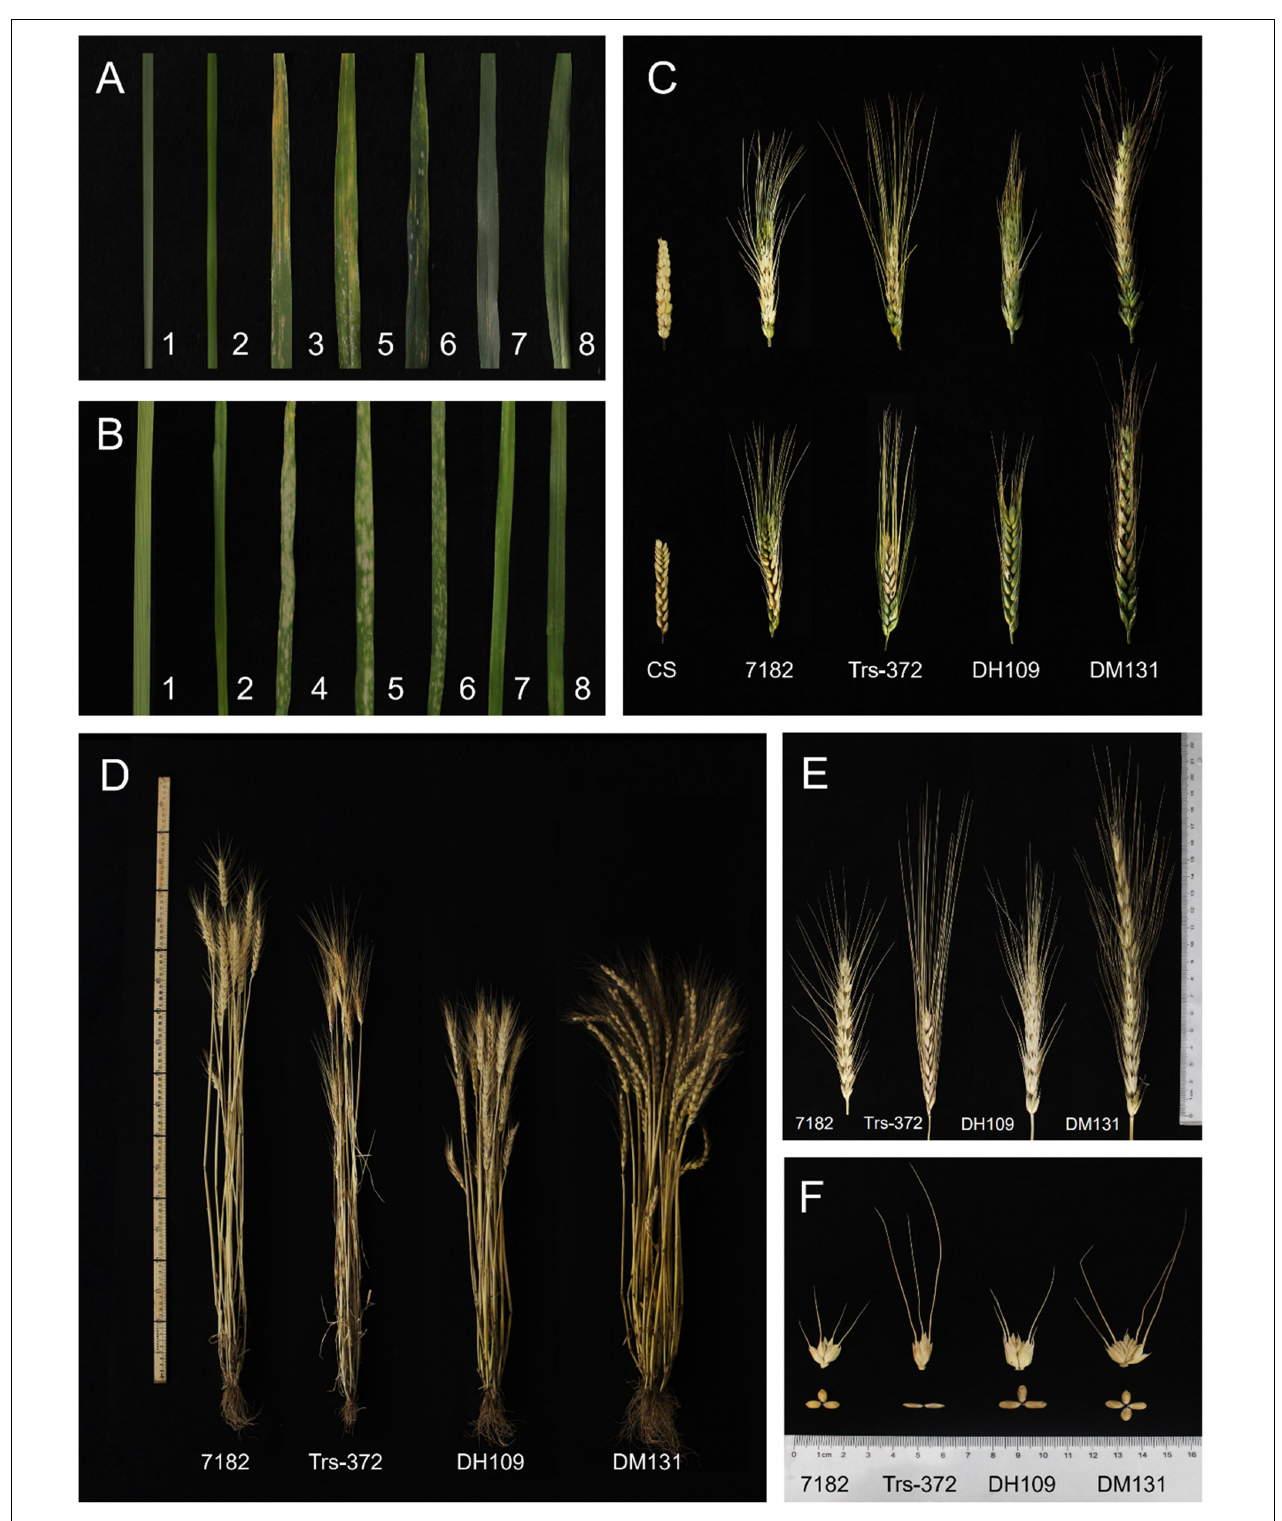
FIGURE 8 | Diseases resistance and agronomic traits of DH109 and DM131, their wheat parents, and controls. (A) Symptoms in response to inoculation with a mixture of Pst races in the adult stage. (B) Symptoms in response to inoculation with a mixture of Bgt isolate E09 in the seeding stage. (C) Spike symptoms after injection with Fusarium graminearum . (D) Plants of materials. (E) kernels of materials. (F) Spikes of materials. The materials in the Figure are 1, L. mollis ; 2, P. huashanica ; 3, control Mingxian 169; 4, control Huixianhong; 5, common wheat 7182; 6, durum wheat Trs-372; 7, line DH109; 8, line DM131.